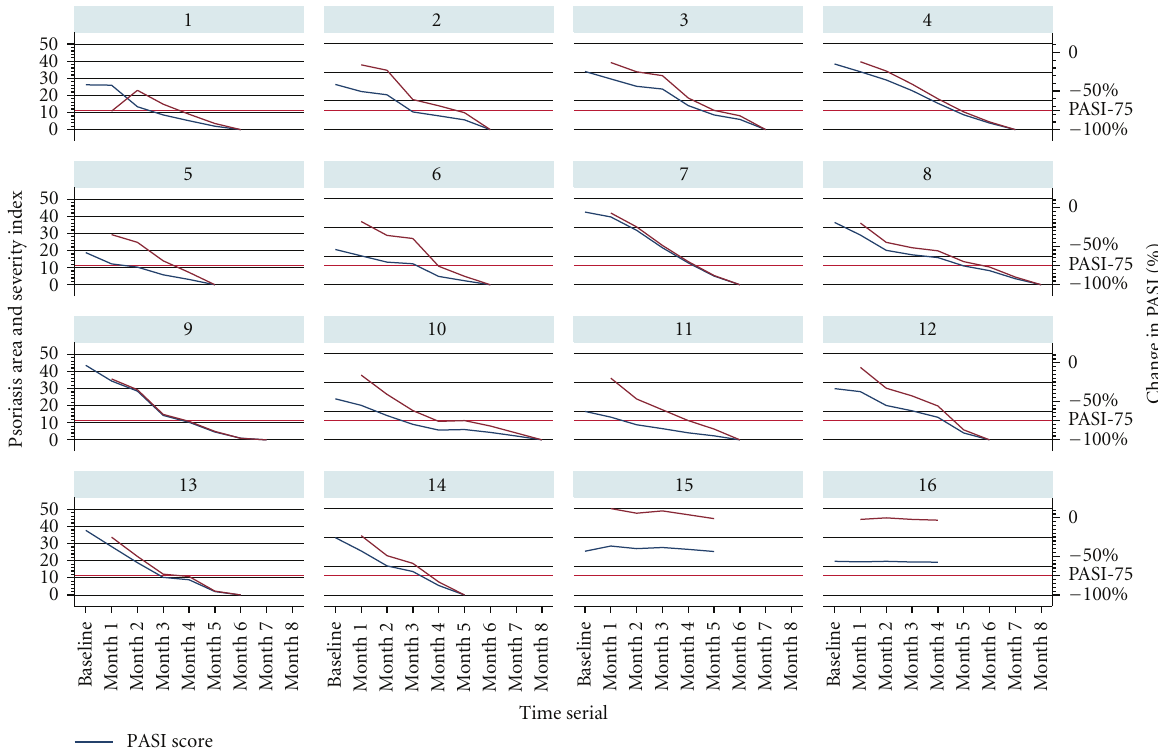
Figure 2: Psoriasis area and severity index scores and percentage change in PASI from the baseline screening to month 8 in 16 psoriasis patients without prior immunosuppressive therapy. After the start of herose, the severity of disease subsided gradually, 14 of 16 patients received complete clearance in 8 months, the mean treatment period to achieve PASI75 improvement is 4.5 months, and the mean subsequent follow-up period after clearance is 30 months; 2 of 16 patients had no clinical response and ceased the medication at month 4 and month 5,